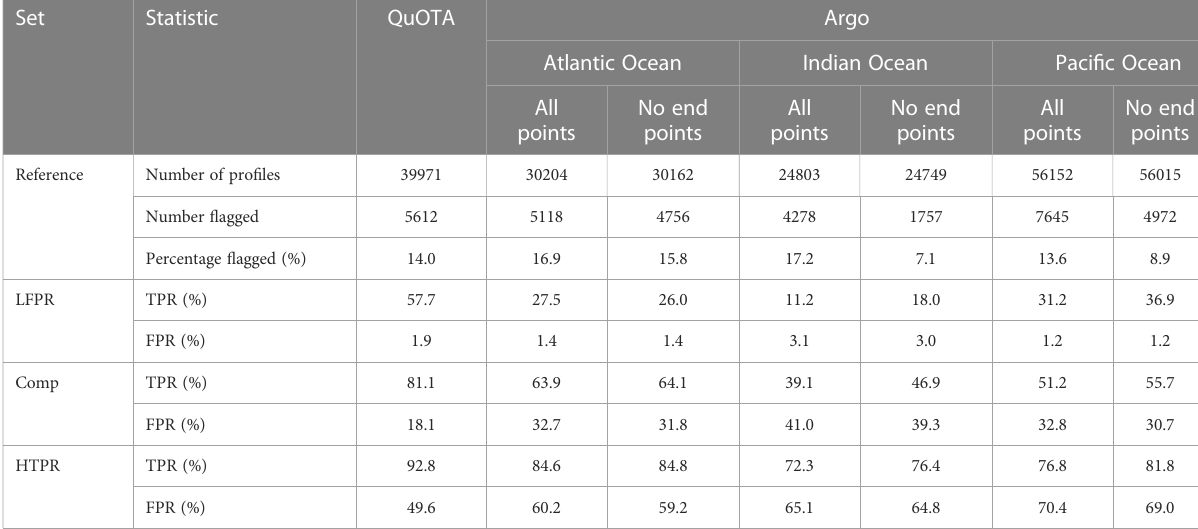
TABLE 6 TPR and FPR for the QuOTA dataset and each of the Argo regional datasets.